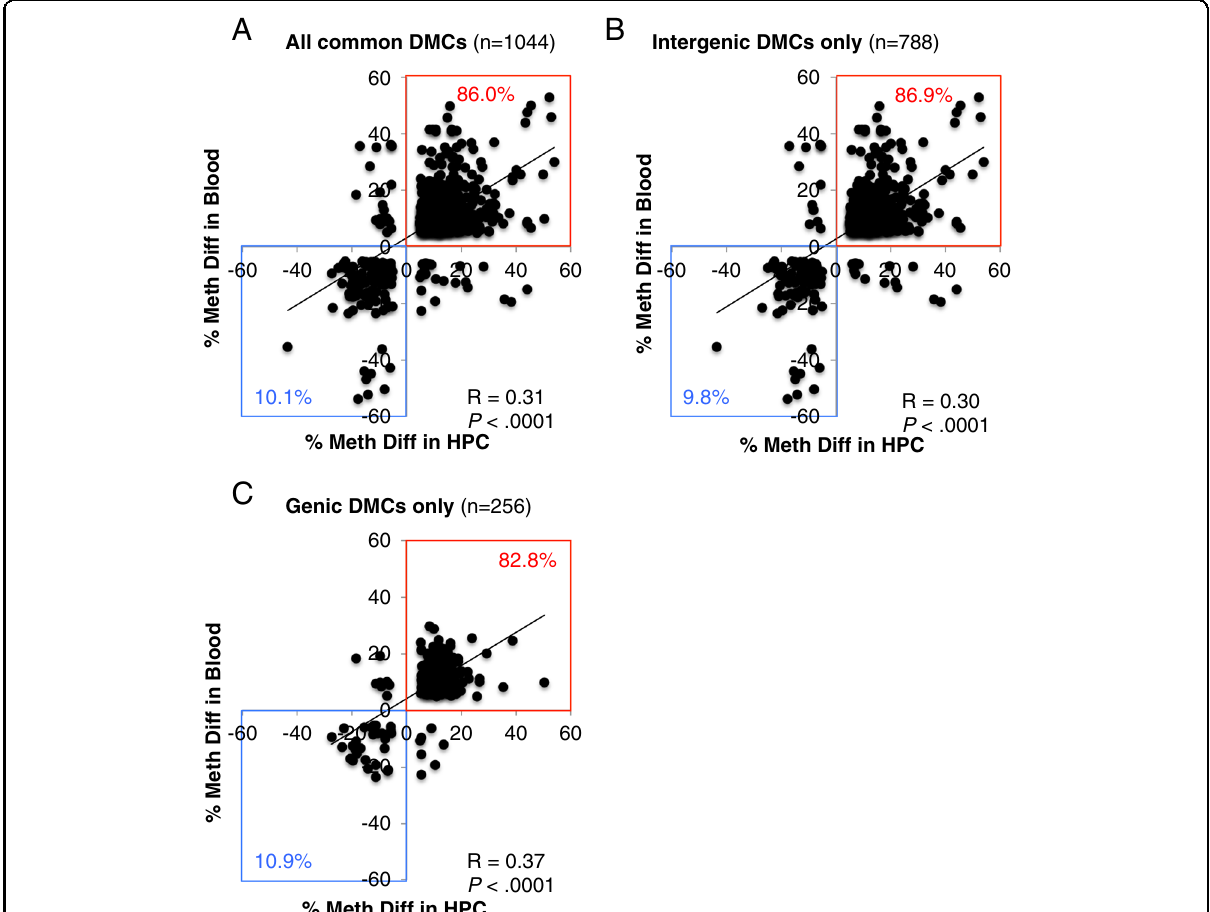
Fig. 2 Methylation percent difference per CpG across the hippocampus (HPC) or whole blood in female offspring born to mothers that received sGC during pregnancy compared to saline controls. A Scatter plot for all DMCs in common between the two tissues ( n = 1044). B Scatter plot for intergenic DMCs in common between the two tissues ( n = 788). C Scatter plot for gene-associated DMCs in common between the two tissues ( n = 256). The red highlighted areas indicate common DMCs that were hypermethylated in both tissues. The blue highlighted areas indicate common DMCs that were hypomethylated in both tissues. Correlation coef fi cients and P -values were determined by Spearman correlations. DMCs were de fi ned as signi fi cant at FDR P < 0.05 and 5% minimum methylation